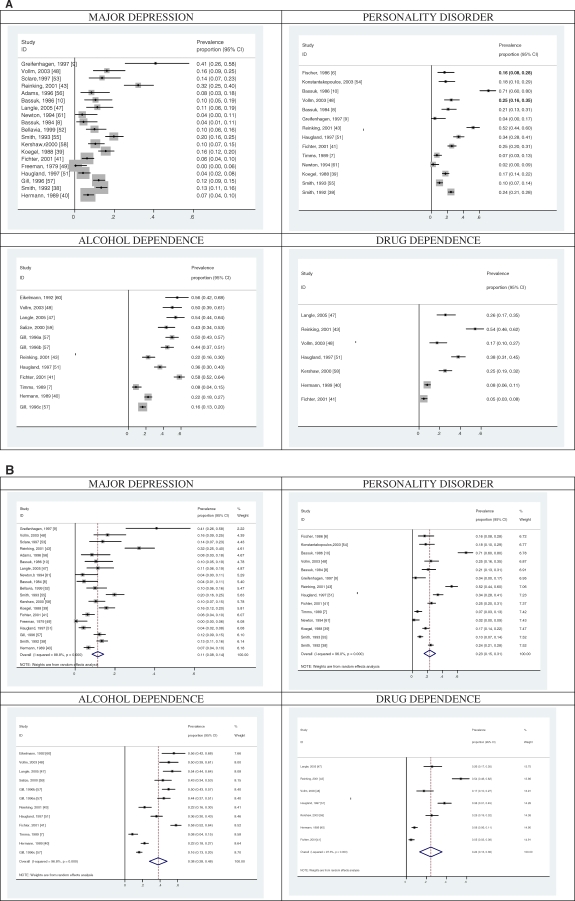
Prevalence of Major Depression, Personality Disorder, Alcohol Dependence, and Drug Dependence in Homeless People(A) Studies are ordered by increasing study weight in a fixed effects model without calculation of an overall estimate.(B) Studies are ordered by increasing study weight and show the overall estimate calculated from random effects meta-analysis.